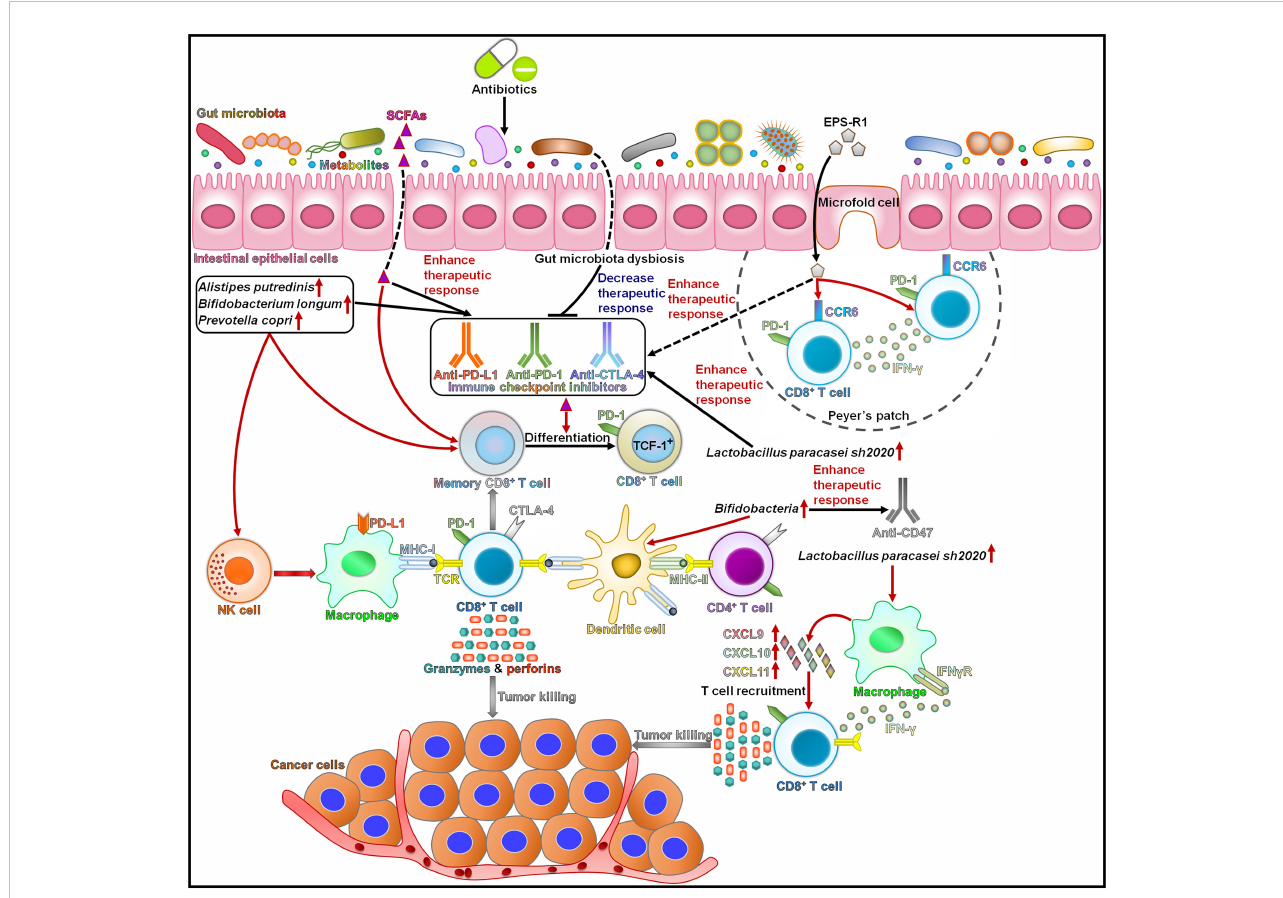
FIGURE 2 The effect of intestinal microbes and their metabolites on the responses to cancer immunotherapy. Intestinal microbes can affect patients ’ responses to immunotherapies through interaction with the host immune system. Alistipes putredinis , Bi fi dobacterium longum , and Prevotella copri can activate NK cells and memory CD8 + T cells and thus enhance the response to anti-PD-1 therapy. SCFAs strengthen the function of memory CD8 + T cells and foster their differentiation into TCF-1 + PD-1 + CD8 + T cells, thus improving the ef fi cacy of anti-PD-1 treatment. Gut microbiota dysbiosis induced by antibiotics results in the poor response to immune checkpoint inhibitors. EPS-R1 can augment the anticancer effects of anti-CTLA-4 and anti-PD-1 treatments by inducing CCR6 + CD8 + T cells in Peyer ’ s patches and fostering their in fi ltration into CCL20-expressing tumors. Lactobacillus paracasei sh2020 promotes the in fi ltration of IFN- g + CD8 + T cells into tumor tissues by increasing the expression of T cell chemoattractant chemokines. Accordingly, L. paracasei sh2020 improves the response to anti-PD-1 therapy. Bi fi dobacteria enhances the ef fi cacy of anti-CD47 therapy through activation of dendritic cells. SCFAs, short-chain fatty acids; EPS-R1, exopolysaccharide produced by Lactobacillus delbrueckii subsp. bulgaricus OLL1073R-1; PD-1, programmed death-1; CCR6, C-C motif chemokine receptor 6; IFN- g , interferon- g ; TCF-1, T cell factor-1, NK cell, natural killer cell; PD-L1, programmed death-ligand 1; MHC-I, major histocompatibility complex class I; TCR, T cell receptor; CTLA-4, cytotoxic T lymphocyte-associated antigen-4; MHC-II, major histocompatibility complex class II; CXCL9, C-X-C motif chemokine ligand 9; CXCL10, C-X-C motif chemokine ligand 10; CXCL11, C-X-C motif chemokine ligand 11; IFN g R, interferon- g